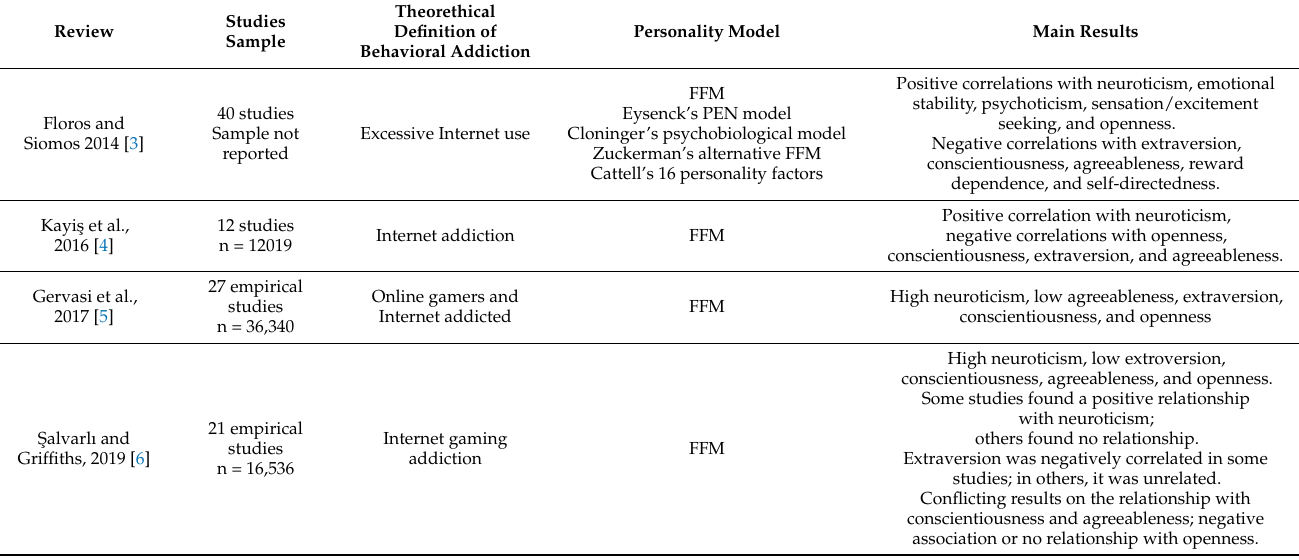
Table 1. Personality traits and addictive behaviors in the systematic